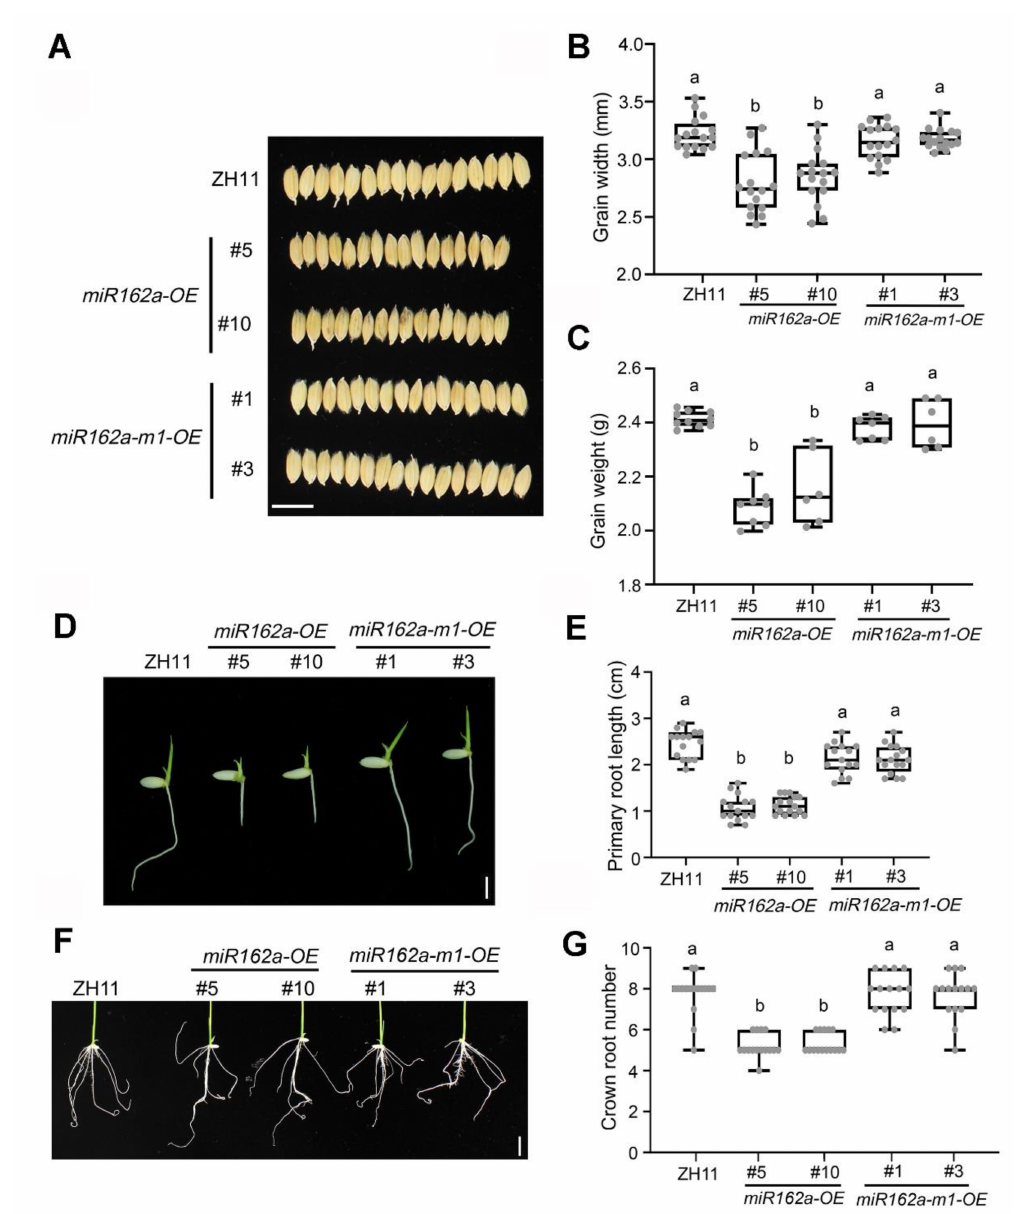
Figure 4. Overexpression of osa-miR162a, but not osa-miR162a-m1, impairs root and grain development in rice. ( A ) Grain development is affected by overexpression (OE) of osa-miR162a, but not osa-miR162a-m1. Scale bar = 1 cm. ( B ) Grain width ranges of 16 randomly selected seeds of indicated genotypes. ( C ) Weight of 100 grains of indicated genotypes. At least six randomly pooled seeds (100 per pool) were evaluated for each genotype. ( D ) Primary root length of three-day-old seedlings is affected by overexpression of osa-miR162a, but not osa-miR162a-m1. Scale bar = 0.5 cm. ( E ) Primary root length quantified using 15 randomly selected seedlings. ( F ) Crown root number of seven-day-old seedlings is affected by overexpression of osa-miR162a, but not osa-miR162a-m1. Scale bar = 0.5 cm. ( G ) Quantification of the crown root number using 15 randomly selected seedlings. In ( B , C , E , G ), measurements are plotted as boxes and whiskers displaying mean ± SD. Individual data points are shown as dots. Significant differences were determined using one-way ANOVA followed by Tukey post hoc test. Letters indicate significantly different